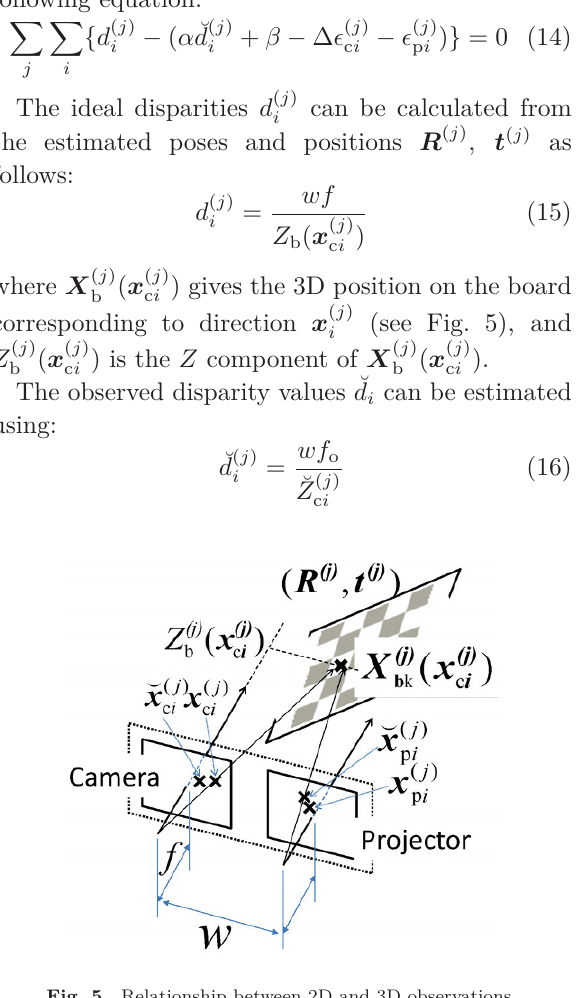
Fig. 5 Relationship between 2D and 3D